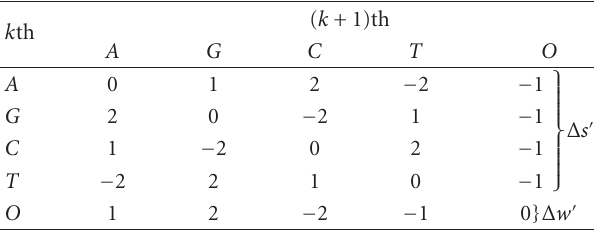
Table 4: Possible values of Δ s (cid:7) and Δ w (cid:7) . The corresponding values of Δ s (cid:7) and Δ w (cid:7) are obtained by substituting the value of x (cid:7) k and x k +1 into (4), with Δ w (cid:7) / = 0 only if x (cid:7) k =